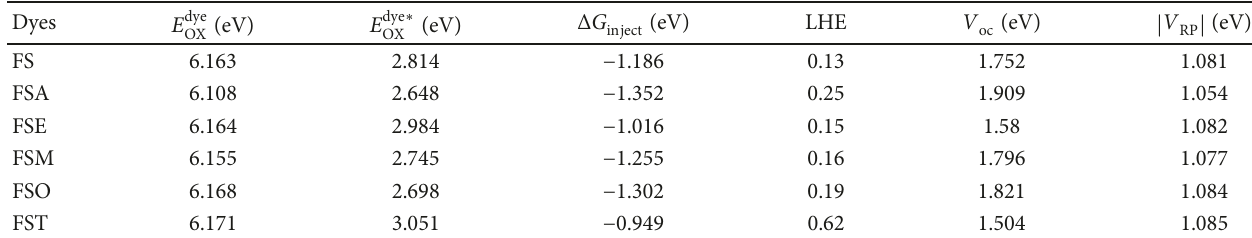
Table 2: Photovoltaic properties of dyes in a solvent